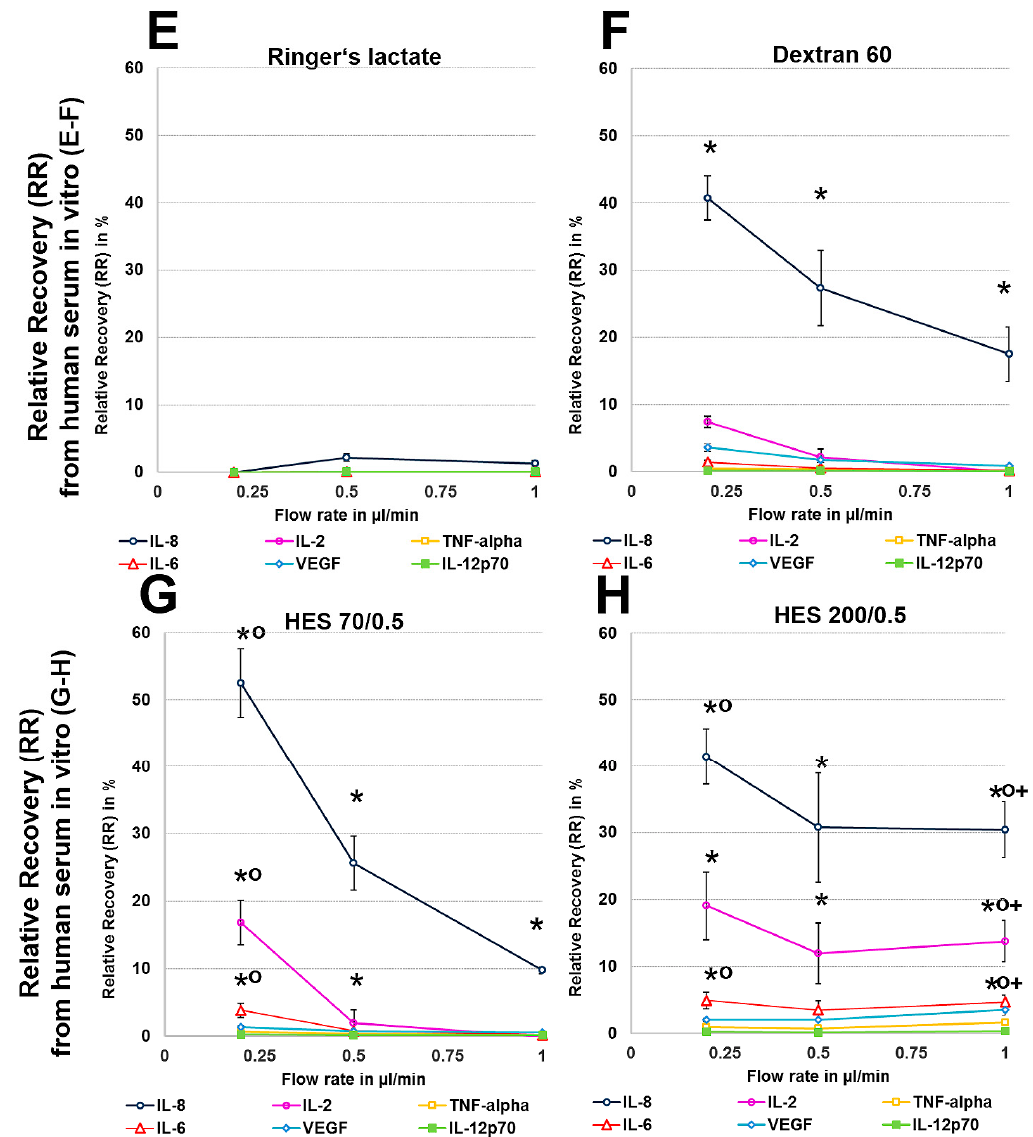
Figure 2. ( A – H ): Effect of different colloid perfusates (dextran 60 ( B , F ), hydroxyethyl starches (HES) 70/0.5 ( C , G ) and 200/0.5 ( D , H ) and the crystalloid Ringer’s lactate solution ( A , E )) on relative recovery (RR) in Ringer’s lactate solution ( A – D ) and human serum ( E – H ) Each figure represents the mean values with standard deviation of three independent experiments of all six cytokines at flow rates of 0.2, 0.5 and 1 µL/min. Significance ( p < 0.05) is indicated by *, x, o and +. * shows significant differences compared with Ringer’s lactate, x shows significant differences when compared with HES 200/0.5, + shows significant differences compared with HES 70/0.5, and o shows significant differences as compared with dextran 60 solution.